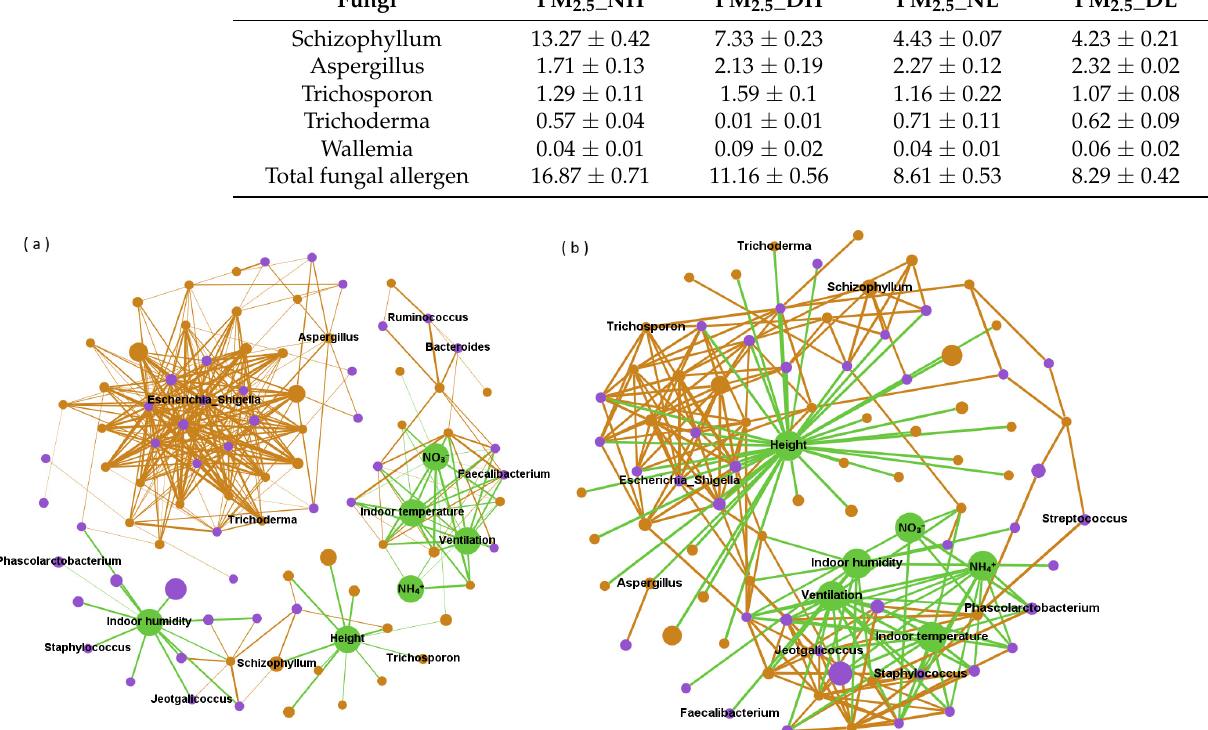
Figure 3. Network of positive ( a ) and negative ( b ) correlations among bacteria (purple), fungi (brown) and environmental parameters (green). Note: The figure shows the relative abundance of the top 50 bacteria and fungi, and the size of the circle corresponds to the level of their relative abundance. The potentially harmful microorganisms and environmental variables were labeled.